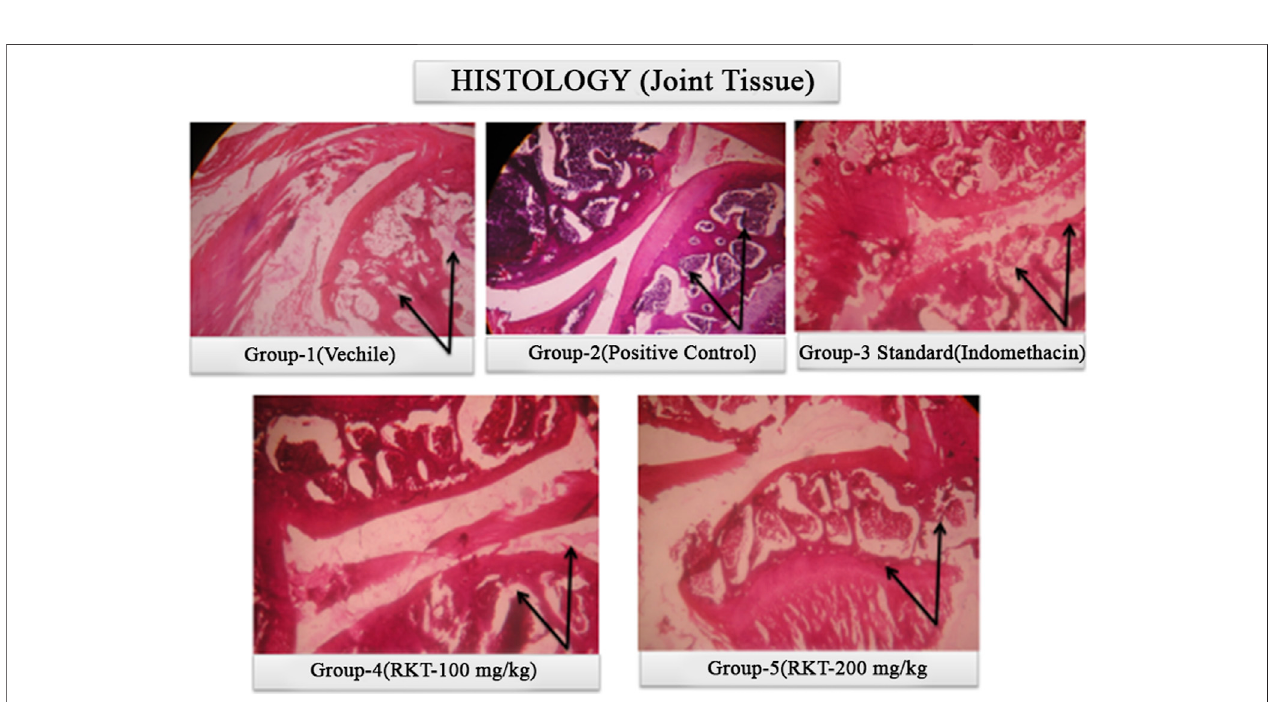
FIGURE 11 | Histopathological study of ankle joint at 21 days of treatment after Complete Freund ’ s adjuvant (CFA) injection.